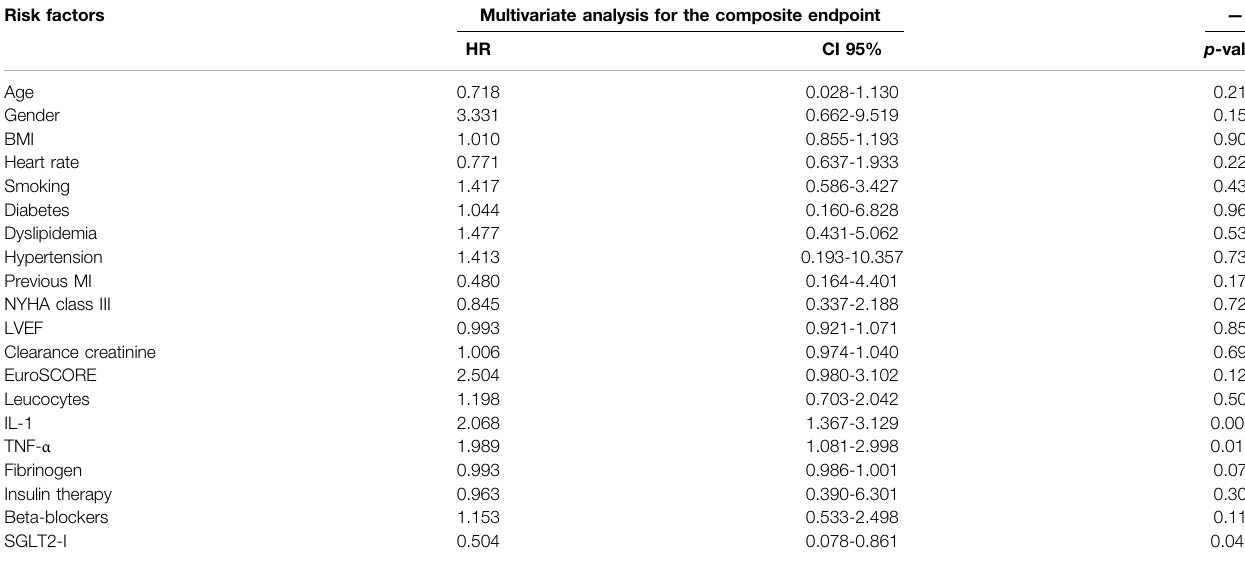
TABLE 3 | Multivariate Cox regression analysis for clinical outcomes at 5 years of follow-up. Risk factors Multivariate analysis for the composite endpoint — HR CI 95% p -value